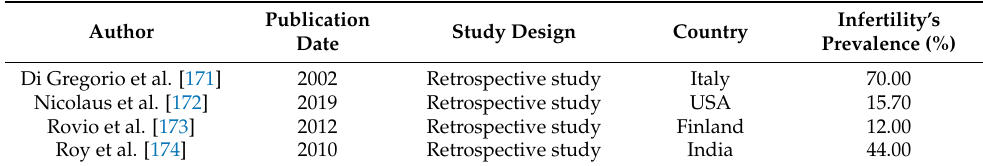
Table 4. Prevalence of infertility in presence of uterine